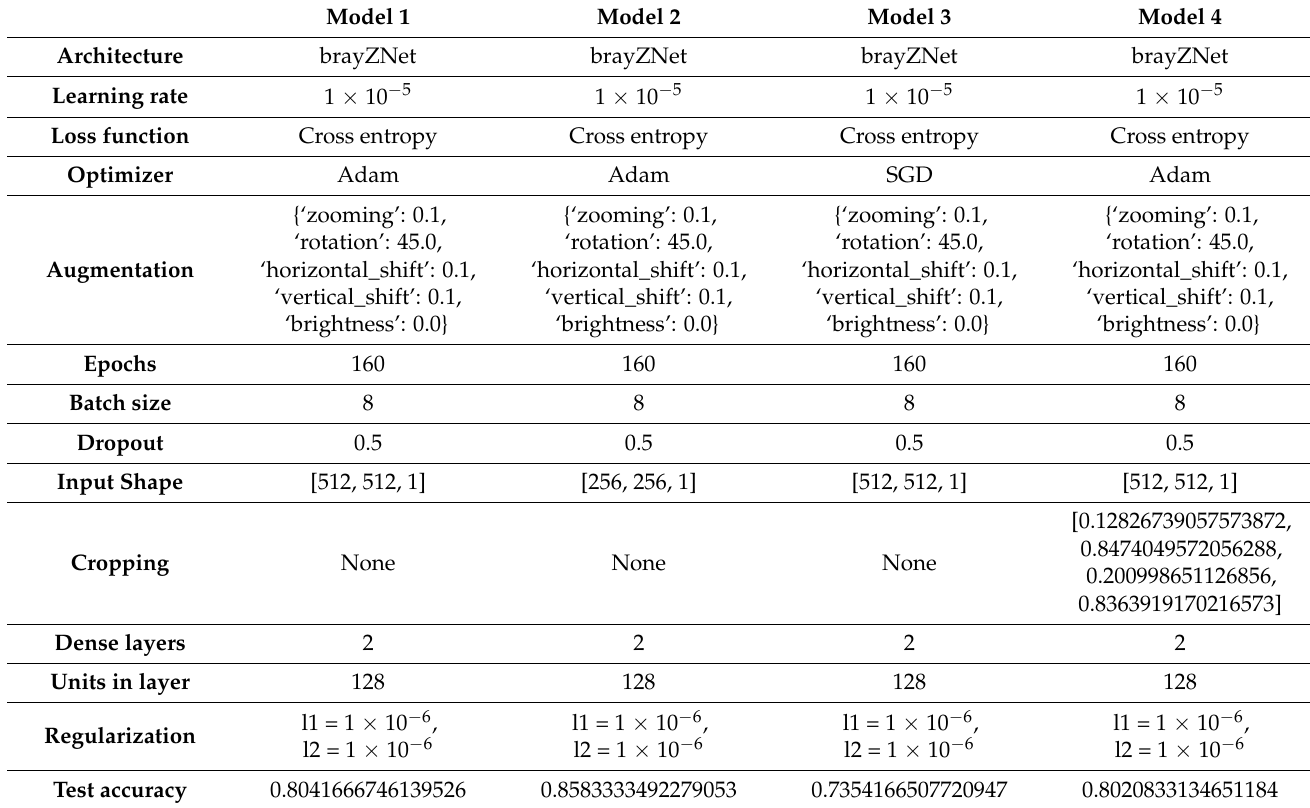
Table 1. Characteristics for each Model of the Deep Convolutional Neural